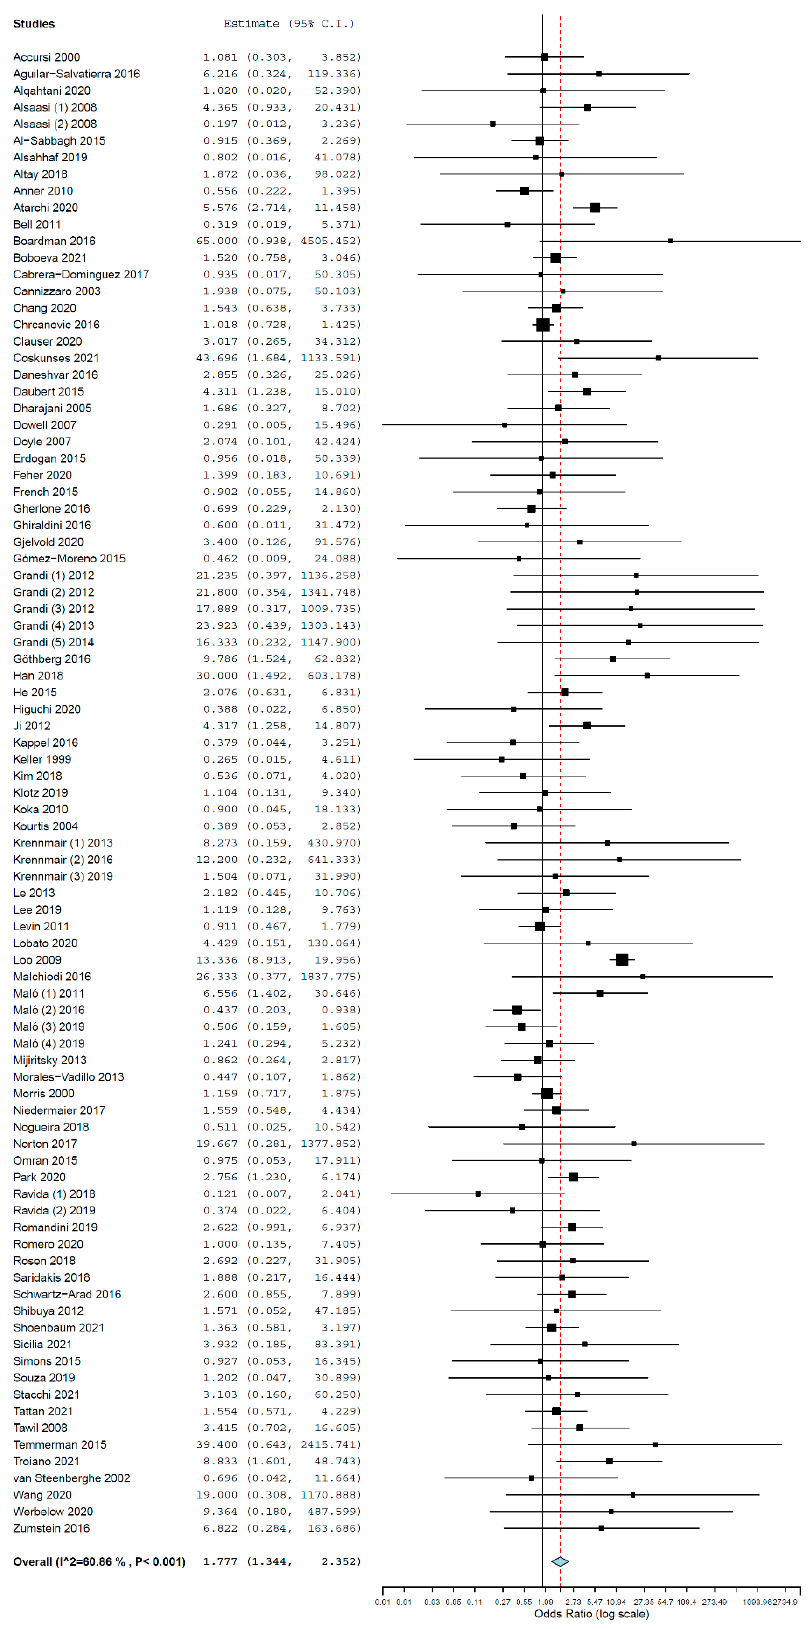
Figure 2. Forest plot for the event ‘implant failure’, global results.